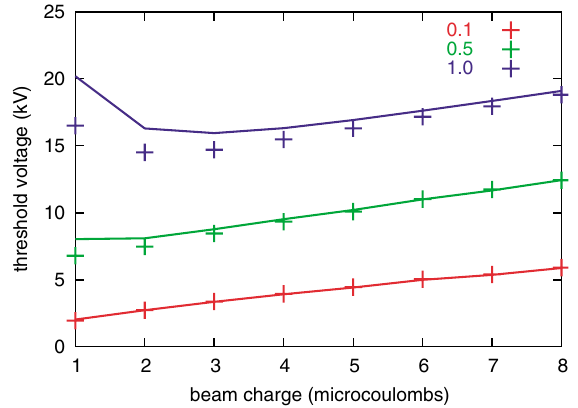
FIG. 14. (Color) Threshold rf voltage for PSR as a function of space-charge tune shift with (cid:6) (cid:5) 0 : 143 . (cid:26) Q sc